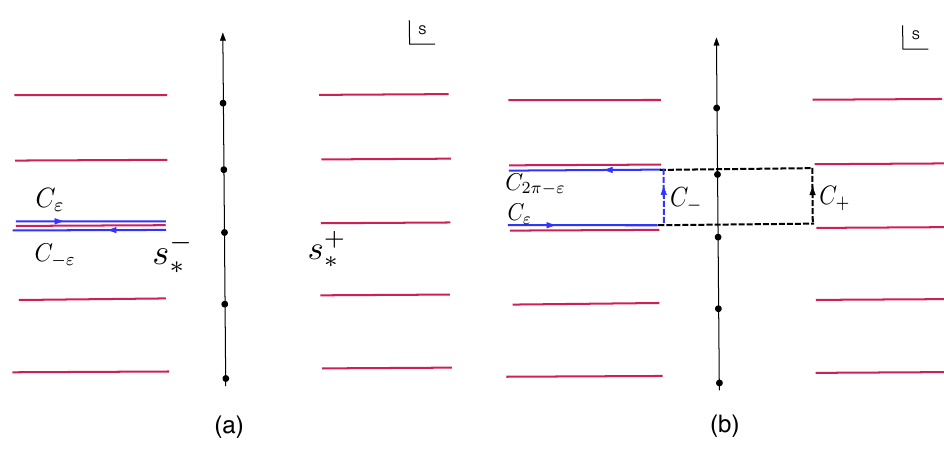
Figure 6 . The analytic structure in the complex s -plane. The original integral is over the solid blue lines. On the future horizon, we complete the contour by including the dashed blue lines. On the past horizon, we complete it by including the dashed grey line at s (cid:0) where in the second line above, we have written the Wightman propagators K (cid:6) in